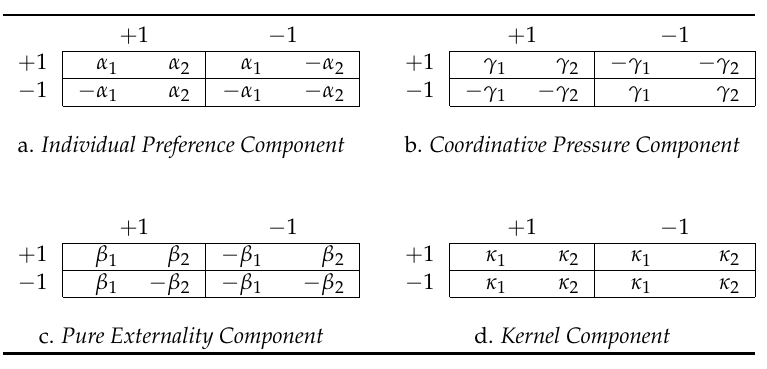
Table 3. The Four Components of a 2 × 2